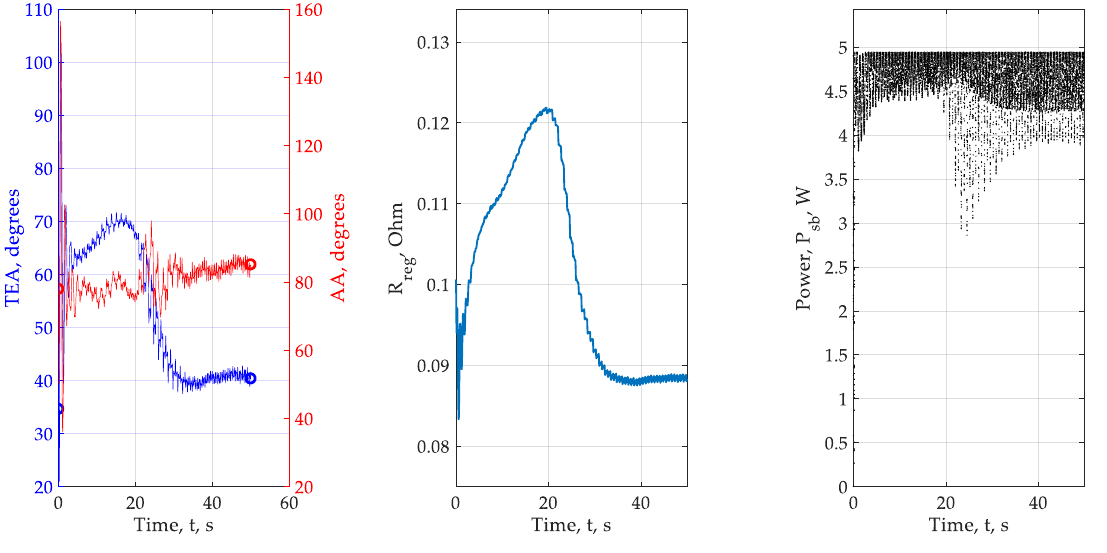
Figure 13. Experiment No.4 — Lo Brano, 2010.